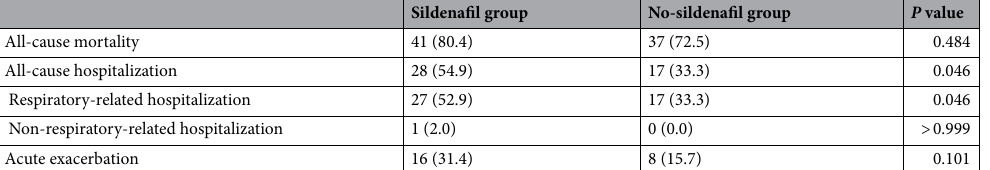
Table 2. Comparison of clinical outcomes for patients with idiopathic pulmonary fibrosis between the sildenafil and no-sildenafil groups. Data are presented as number (%). The median follow-up durations were 7.0 and 8.0 months in the sildenafil and no-sildenafil groups, respectively ( p = 0.139).